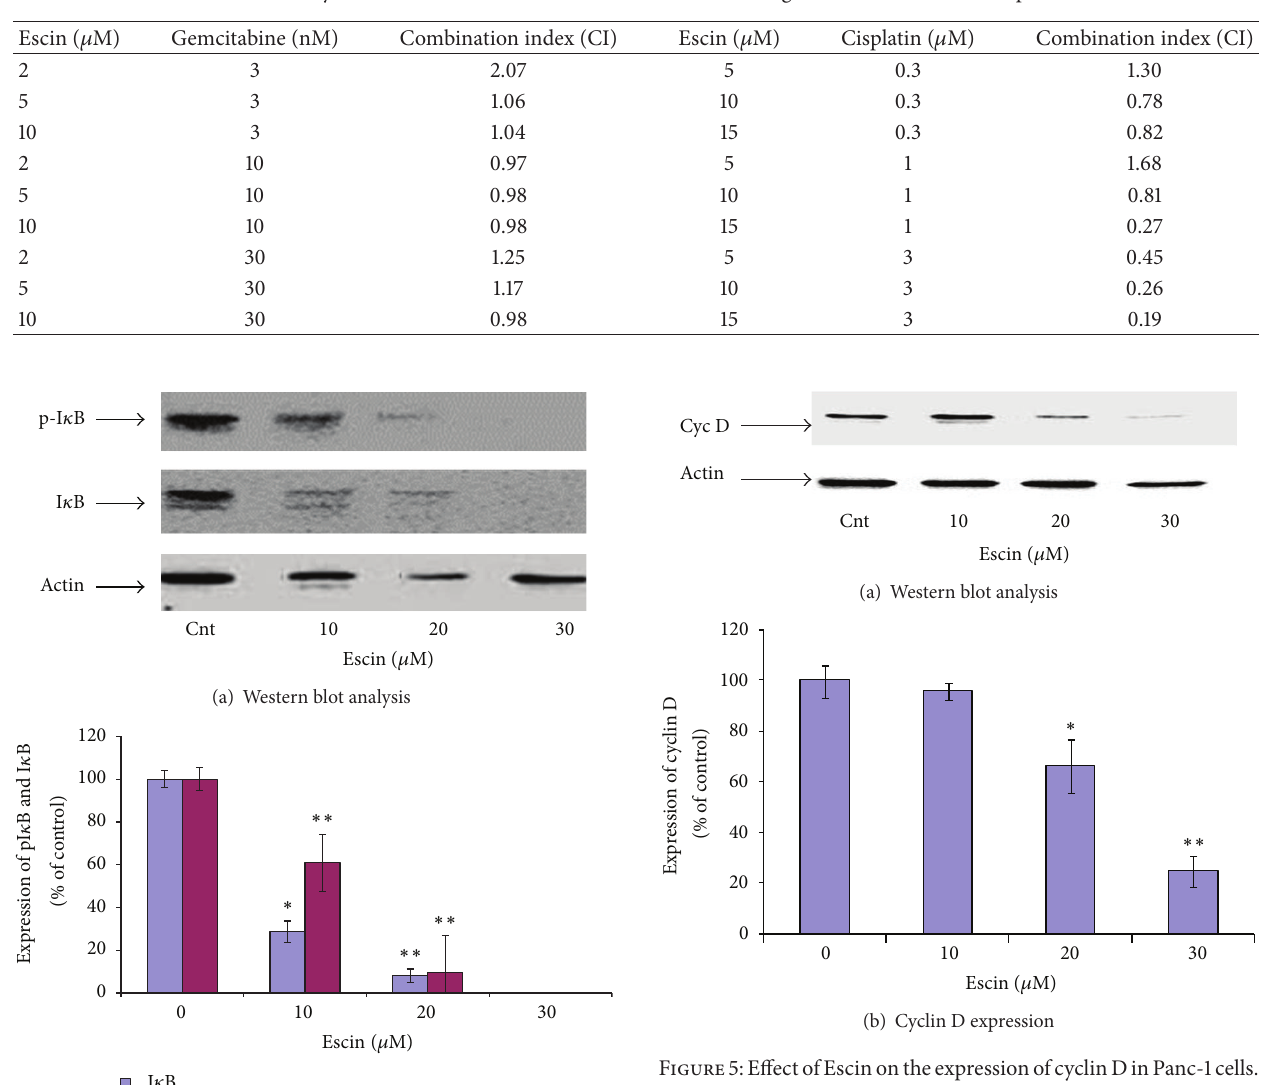
Table 1: Analysis of a mode of combined treatment with Escin + gemcitabine or Escin + cisplatin.